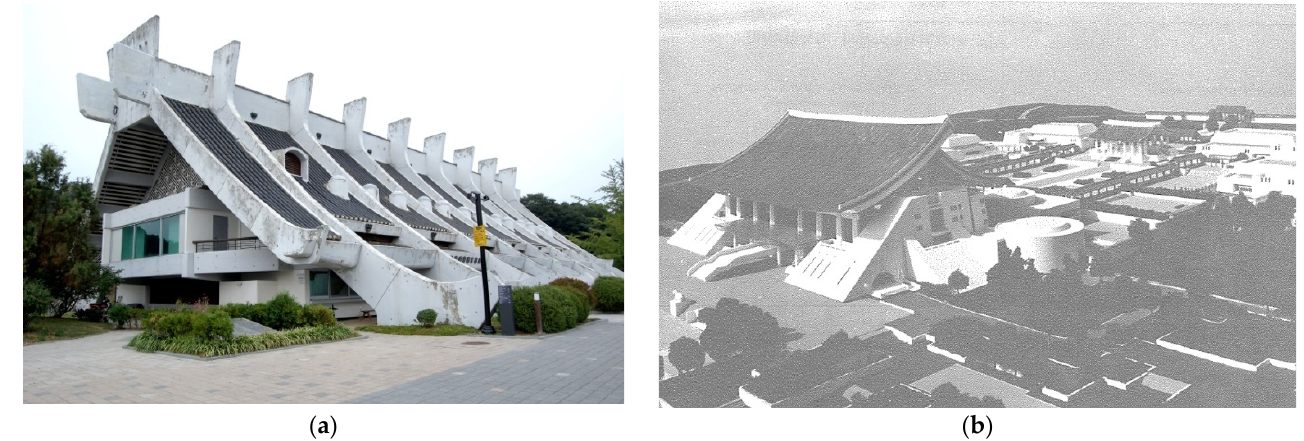
Figure 18. ( a ) Buyeo National Museum (doopedia) ( b ) Independence Hall of Korea (1983, Korean Architects ) [33].